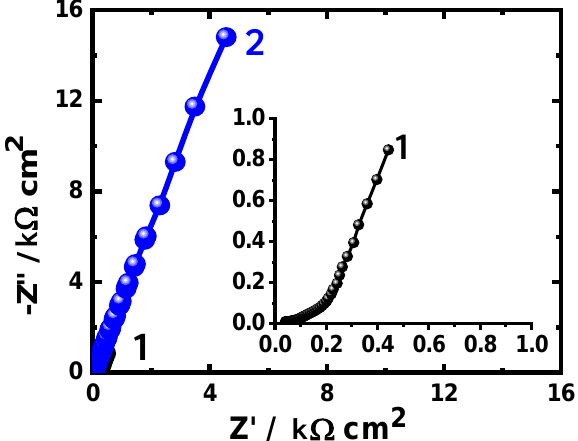
Figure 6. Nyquist plots measured for (1) Ti-6%Al and (2) Ti-6%Al-4%V alloys after immersion in 3.5% NaCl solution for 24 h.